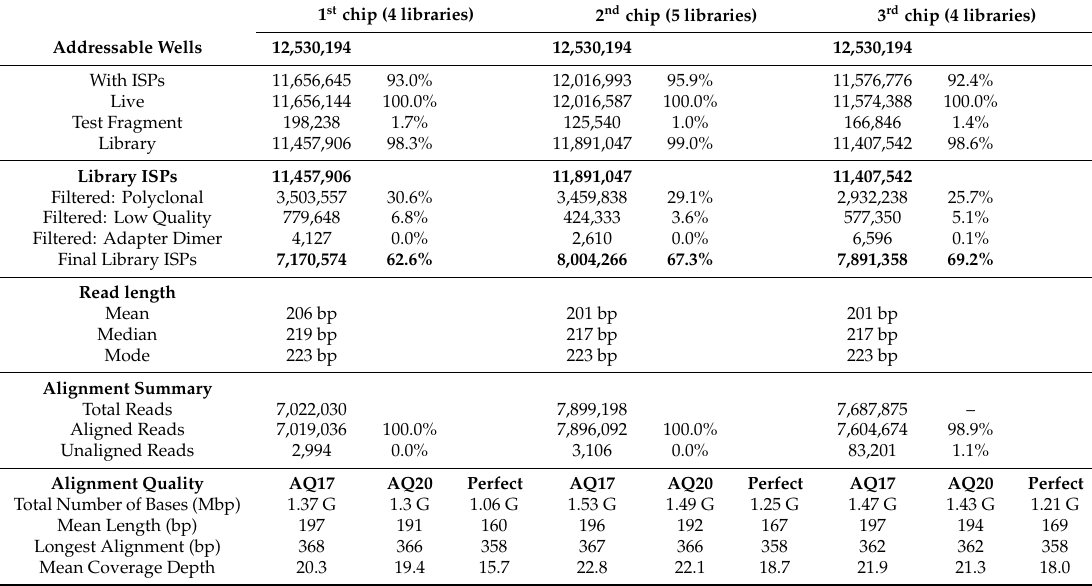
Table 2. Run and alignment summary results of the three